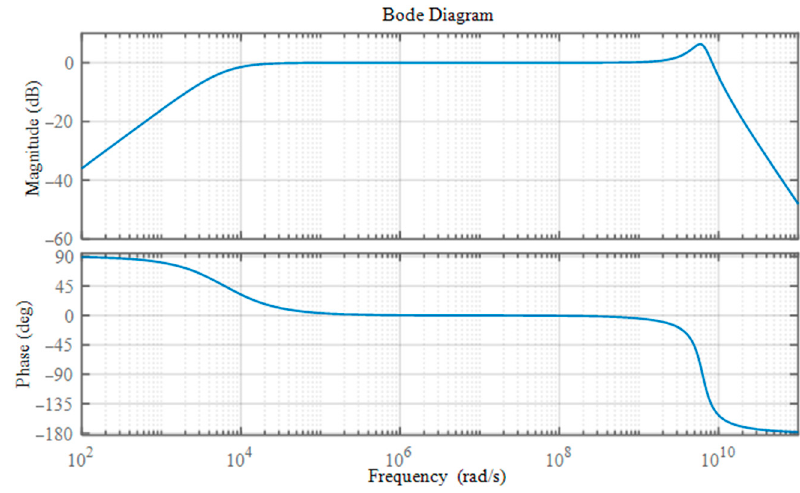
Figure 2. Frequency-response curve of the simulated broadband measurement system. The time-domain output response of the broadband measurement system under square wave excitations with different pulse widths is shown in Figure 3, in which the data sampling frequency is set to 5 GHz.